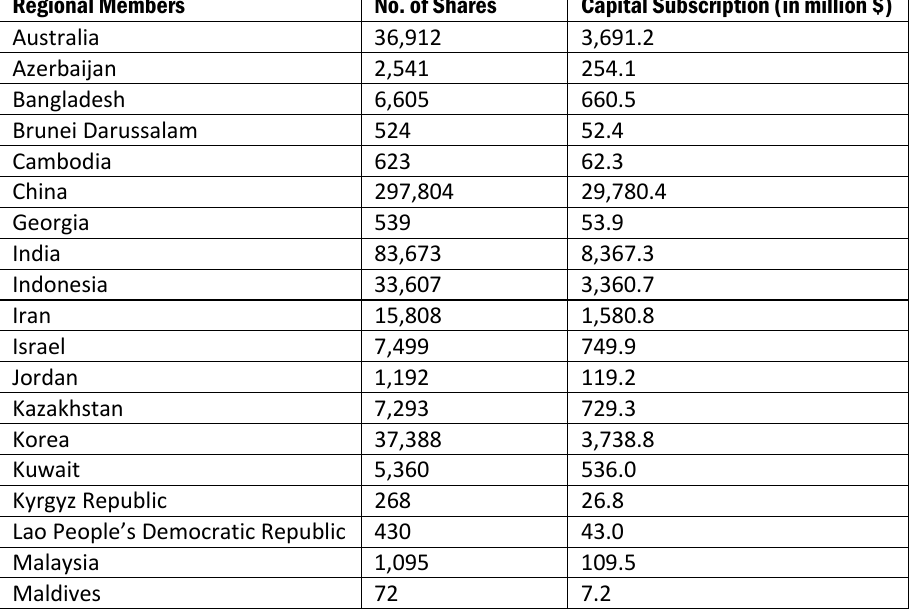
Table 1: The Initial Subscriptions to the Authorized Capital Stock of the AIIB Regional